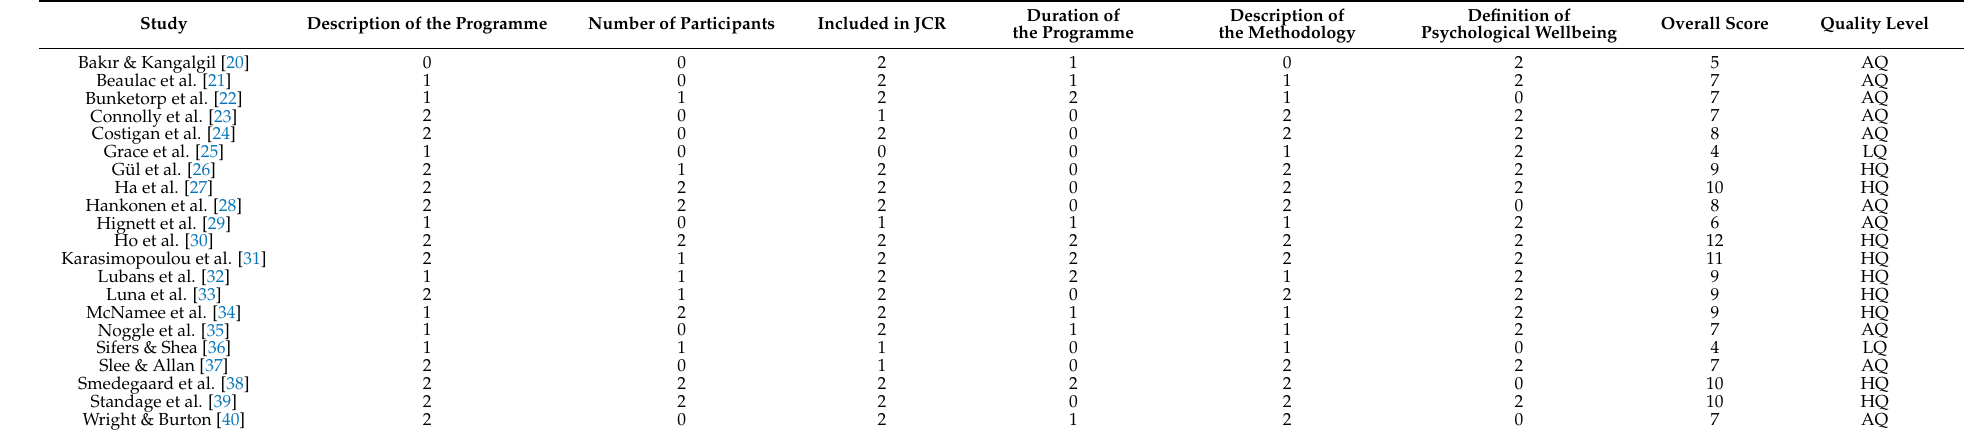
Table 2. Quality of the